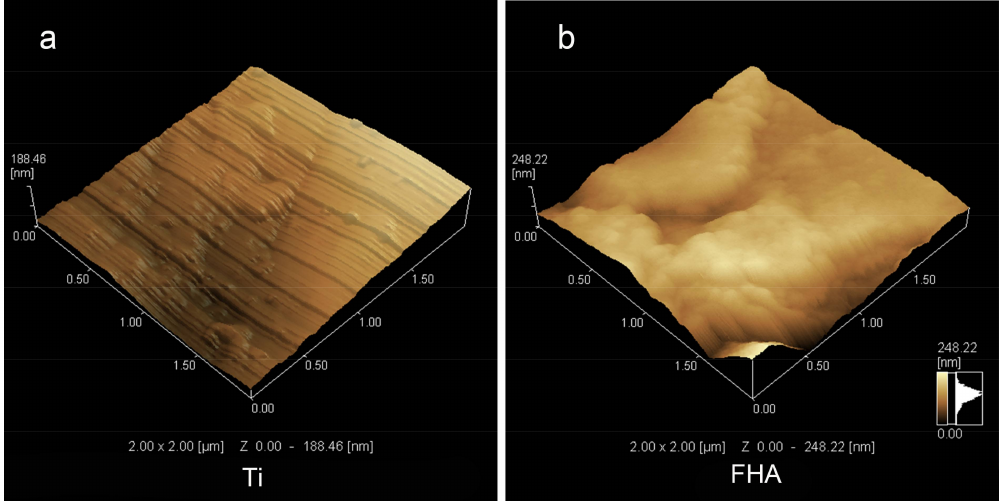
Figure 3. Scanning probe micrographs of ( a ) Ti and ( b ) FHA-coated